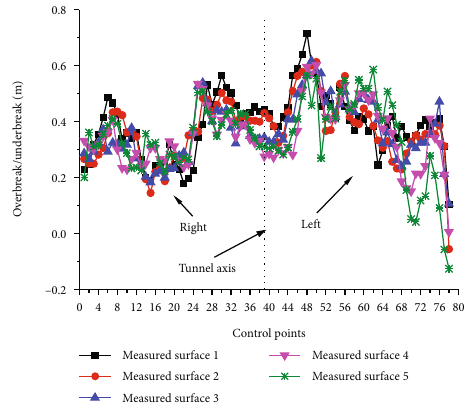
Figure 10: Comparison of the overbreak and underbreak control